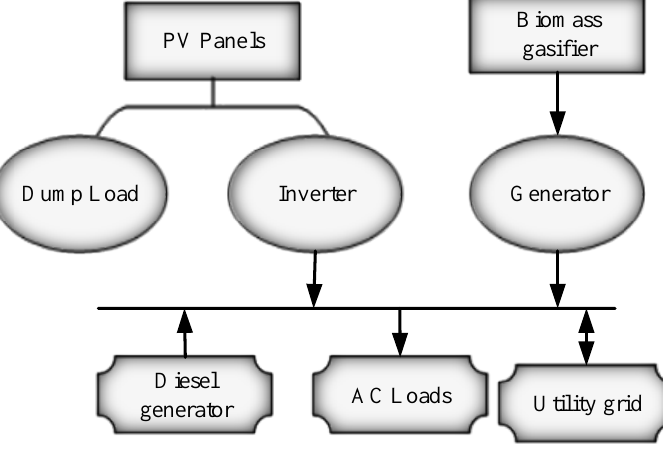
Figure 1. Schematic diagram of hybrid PV-biomass energy system.